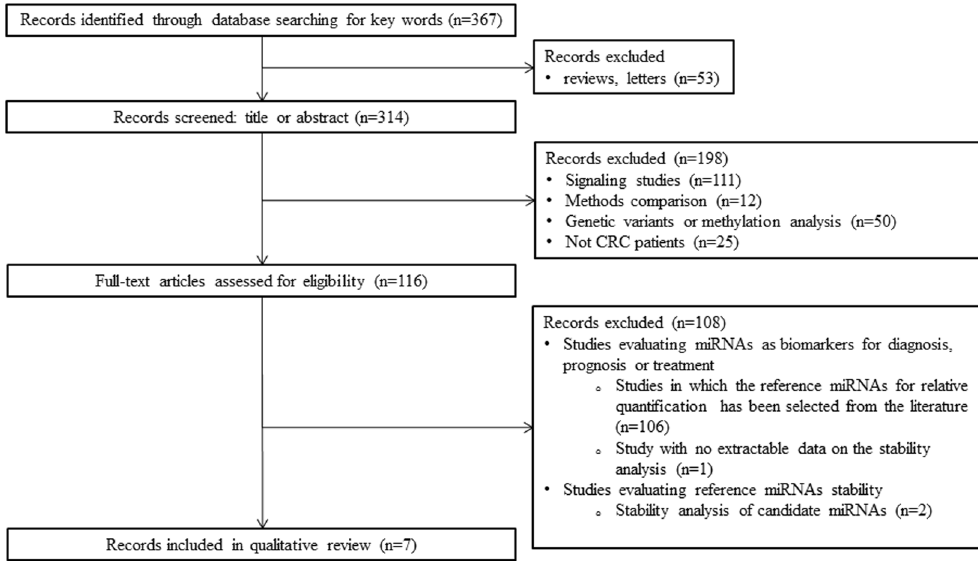
Figure 1. Flow diagram of the study selection